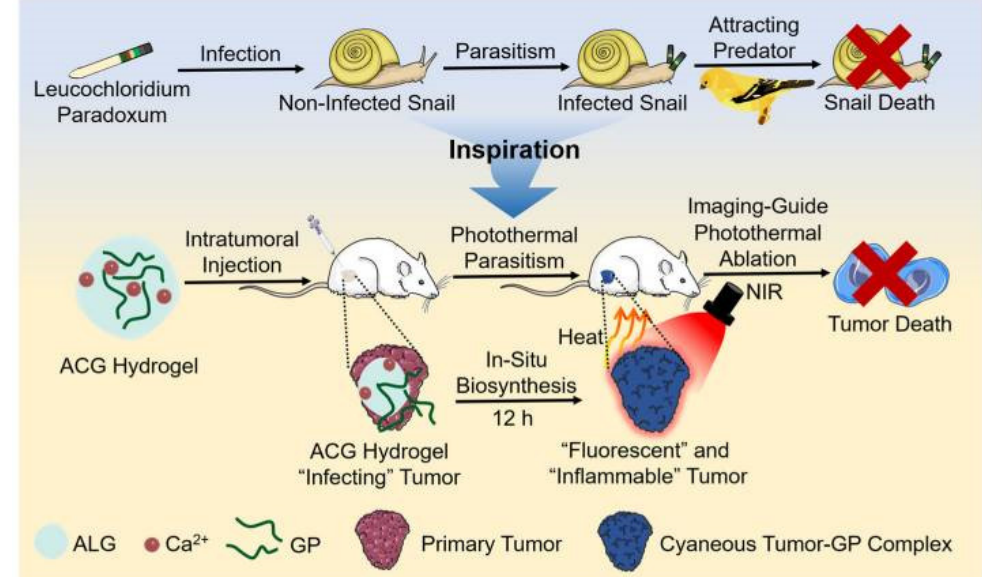
Figure 2. Schematic illustration of in situ biosynthesis of the genipin–protein crosslinking product for fluorescence imaging-guided PTT. Reprinted with permission from [148].